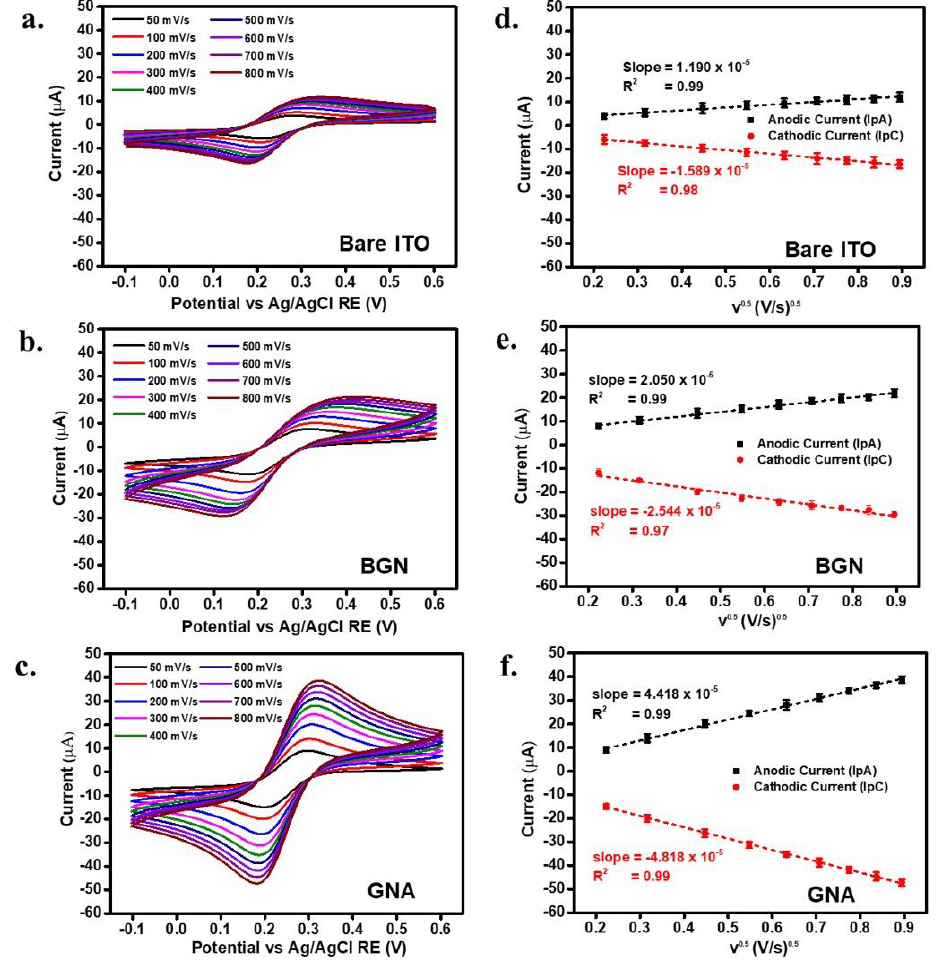
Figure 4. Cyclic voltammograms and the linear relations of the anodic peak current against the scan rate’s square root of the ( a ) and ( d ) bare ITO, ( b ) and ( e ) billowy gold nanostructure (BGN), scan rate’s square root of the ( a , d ) bare ITO, ( b , e ) billowy gold nanostructure (BGN), and ( c , f ) gold and ( c ) and ( f ) gold nanoframe array (GNA) electrodes. nanoframe array (GNA)